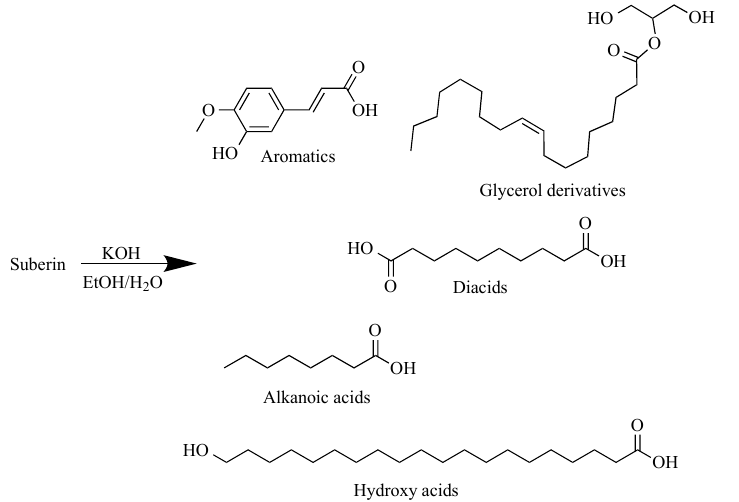
Figure 1. Representative structures of monomeric components resulting from suberin depolymeri- zation.